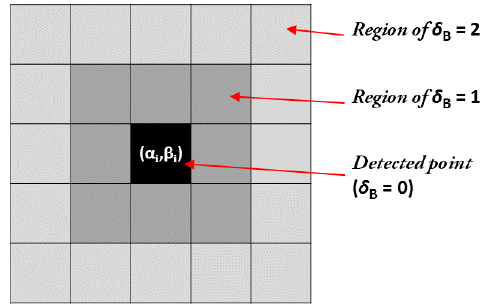
Figure 3. Introduction of error δ B in one of the perfectly detected image point ( α i , β i ) . Adding a noise of | γ | pixel on image point ( α i , β i ) will result into region of δ B = γ . The error in B can be estimated by evaluating area (in µ m 2 ) of the uncertain region using pixel size value from Table